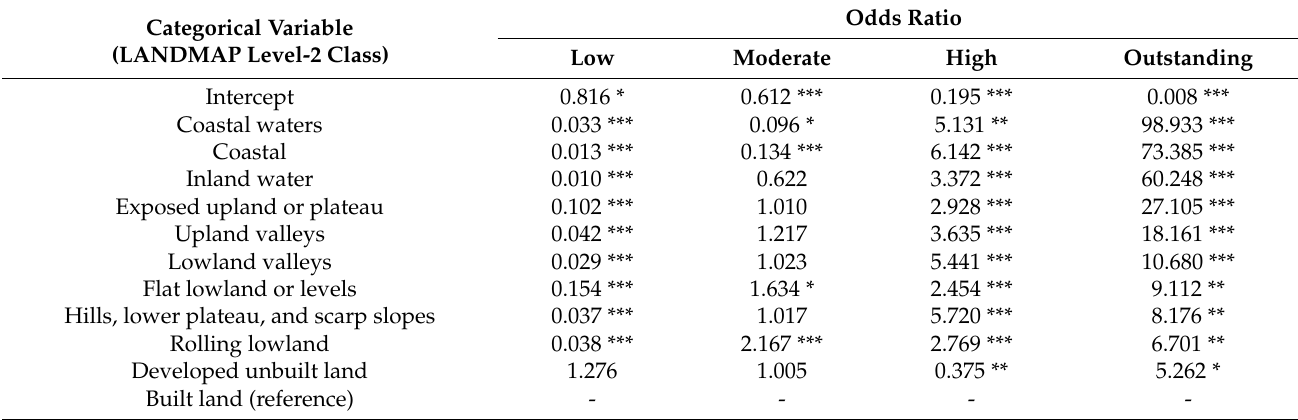
Table 4. Results of the logistic regressions for the four levels of scenic quality evaluated by experts to the level-2 classes which were dummy-coded and the “built land” class was used as the reference category (* p < 0.05, ** p < 0.01, *** p < 0.001).